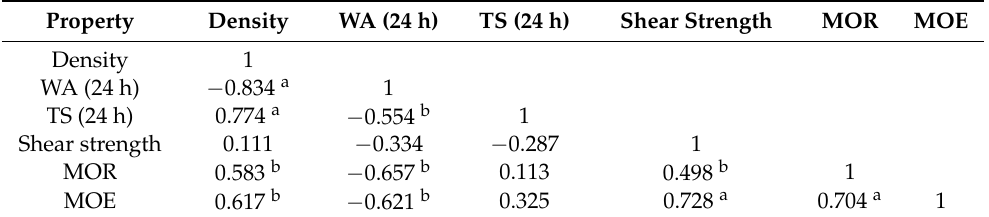
Table 2. Pearson correlation ( r ) for properties versus density of plywood samples.